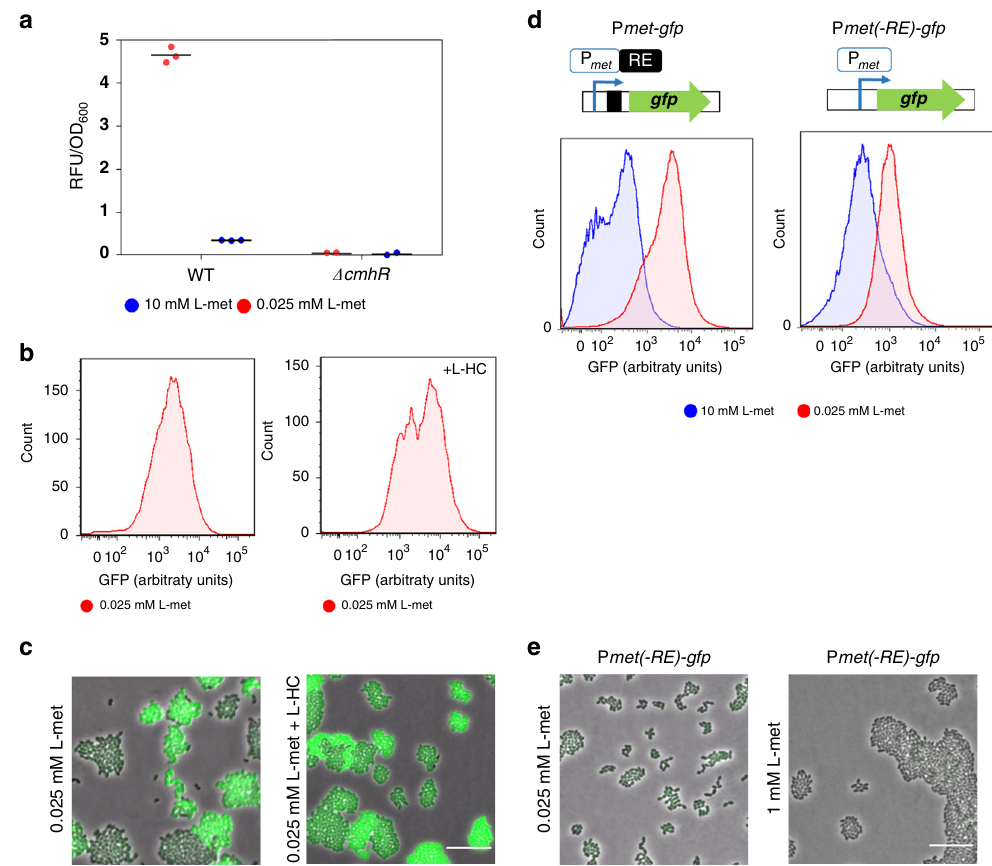
Fig. 5 Transcriptional regulation of the met operon. a Expression of the Met-transporter at the population-level, in the cmhR deletion mutant ( L. lactis Δ cmhR Pmet-gfp) and wild-type ( L. lactis Pmet-gfp ) strains at low (0.025 mM) and high (1 mM) methionine concentrations. Data are presented as mean ± S.D. Error bars represent standard deviation (SD) of the mean values of three independent experiments. b Single-cell fl uorescence measurements by fl ow cytometry, in the L. lactis Pmet-gfp strain in the absence (left) and presence of 0.27 mM L-homocysteine (L-HC; right) (in both cases with 0.025mM methionine; see Supplementary Movies 7 and 8). 10,000 ungated events for each sample are shown. c Snapshots of single-cell fl uorescence microscopy in the L. lactis Pmet-gfp strain in the presence (left) and absence of 0.27 mM L-homocysteine (L-HC; right). Scale bar, 15 µ m. d Single-cell fl uorescence measurements by fl ow cytometry, in the met promoter-driven expression of GFP with ( L. lactis Pmet-gfp ; left) or without the regulatory element in the met promoter ( L. lactis Pmet(-RE)-gfp ; right) at low (0.025 mM) and high (1 mM) methionine concentrations. 10,000 ungated events for each sample are shown. e Snapshots of single-cell fl uorescence microscopy in the L. lactis Pmet(-RE)-gf p strain at low (0.025 mM; left), and high (1 mM; right) methionine concentrations. Scale bar, 15 µ m. Source data are provided as a Source Data fi